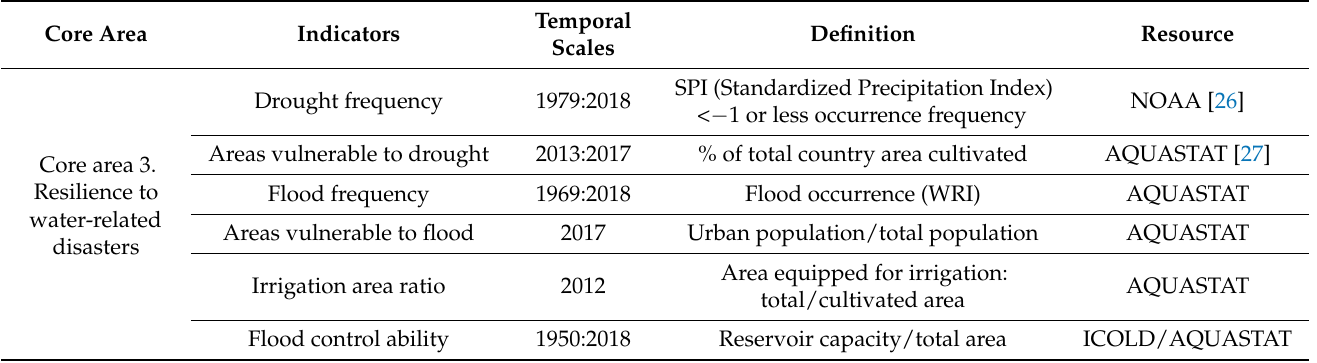
Table 3. Core area 3: indicators and variables of resilience to water-related disasters.